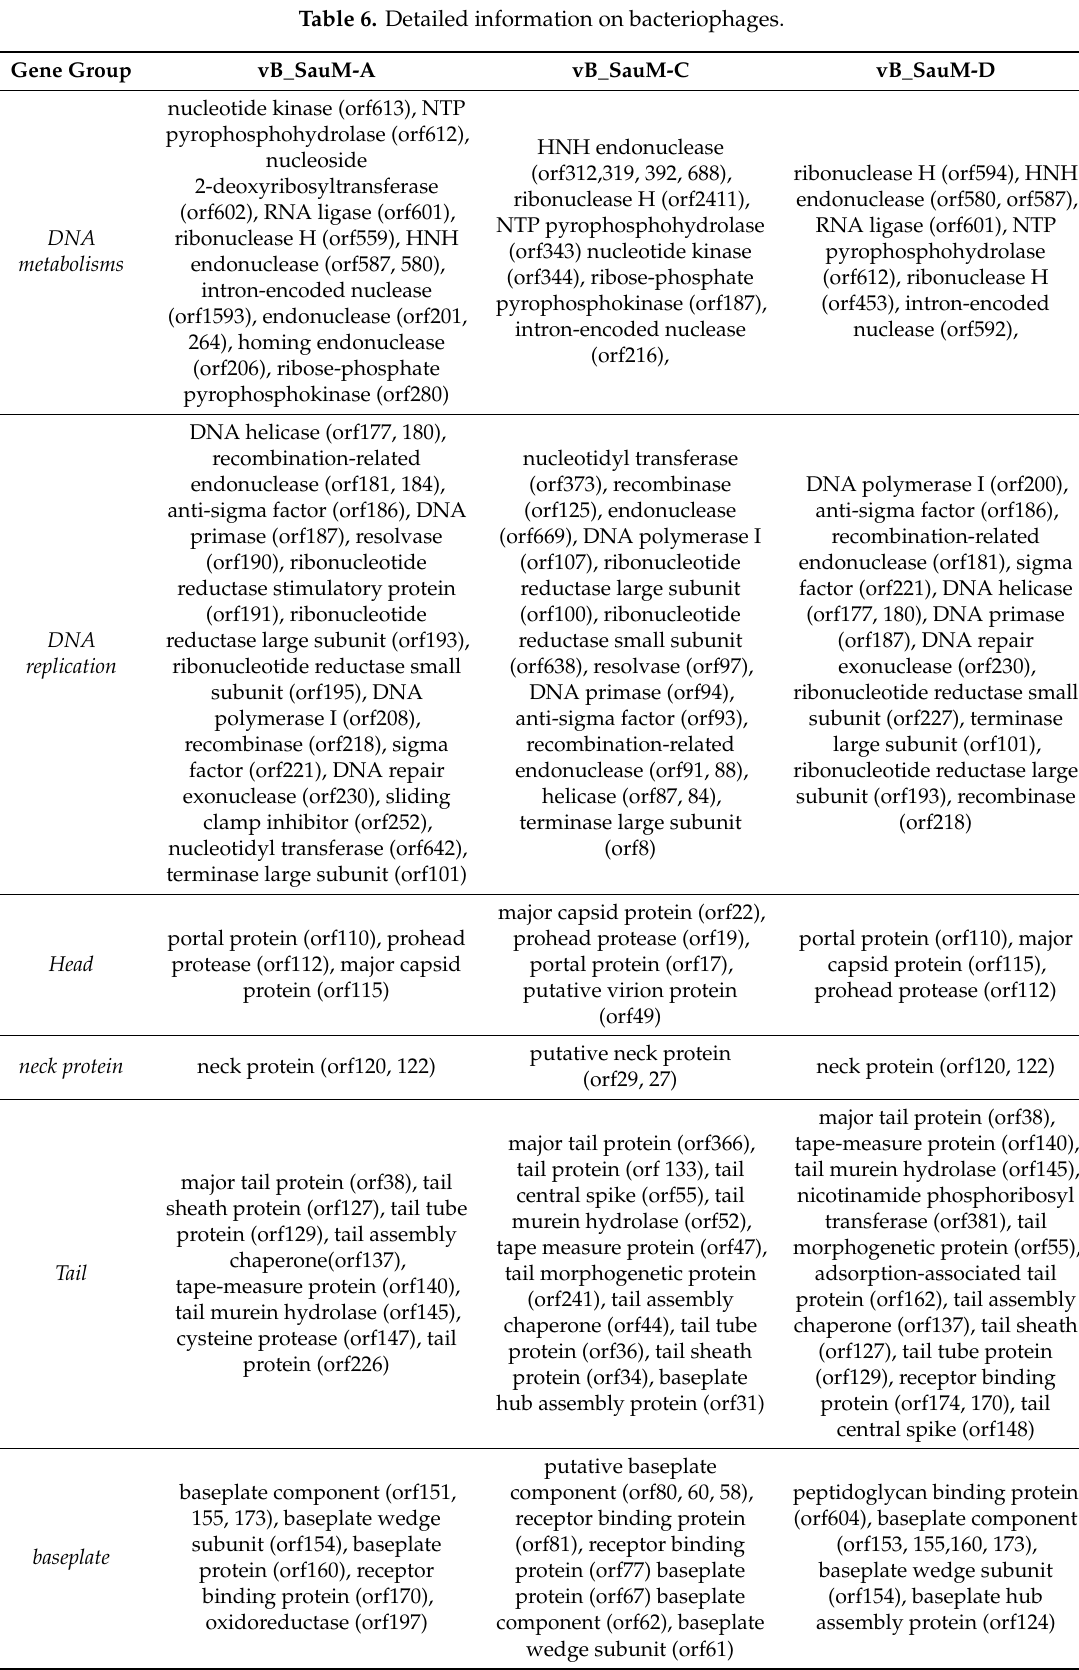
Table 6. Detailed information on